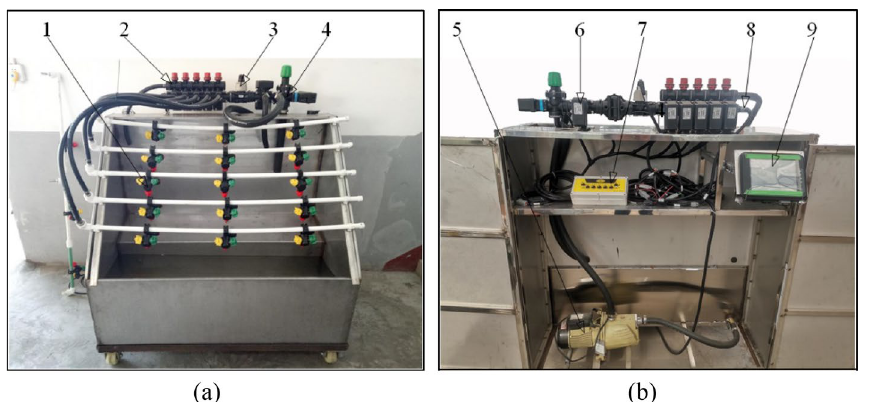
Figure 8. Bench test platform. 1. Spray nozzle; 2. Segmented valve group; 3. Flowmeter; 4. Electric main valve; 5. Self-priming jet pump; 6. Electric proportional valve; 7. Switch box; 8. Pressure sensor; 9. Controller.